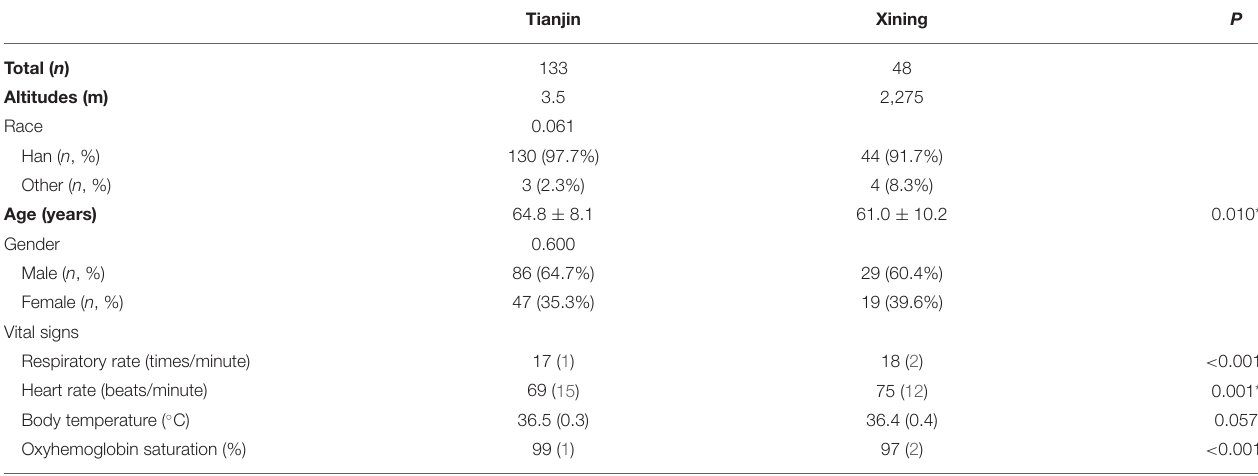
TABLE 1 | Baseline information and Vital signs of the patients at different altitudes.